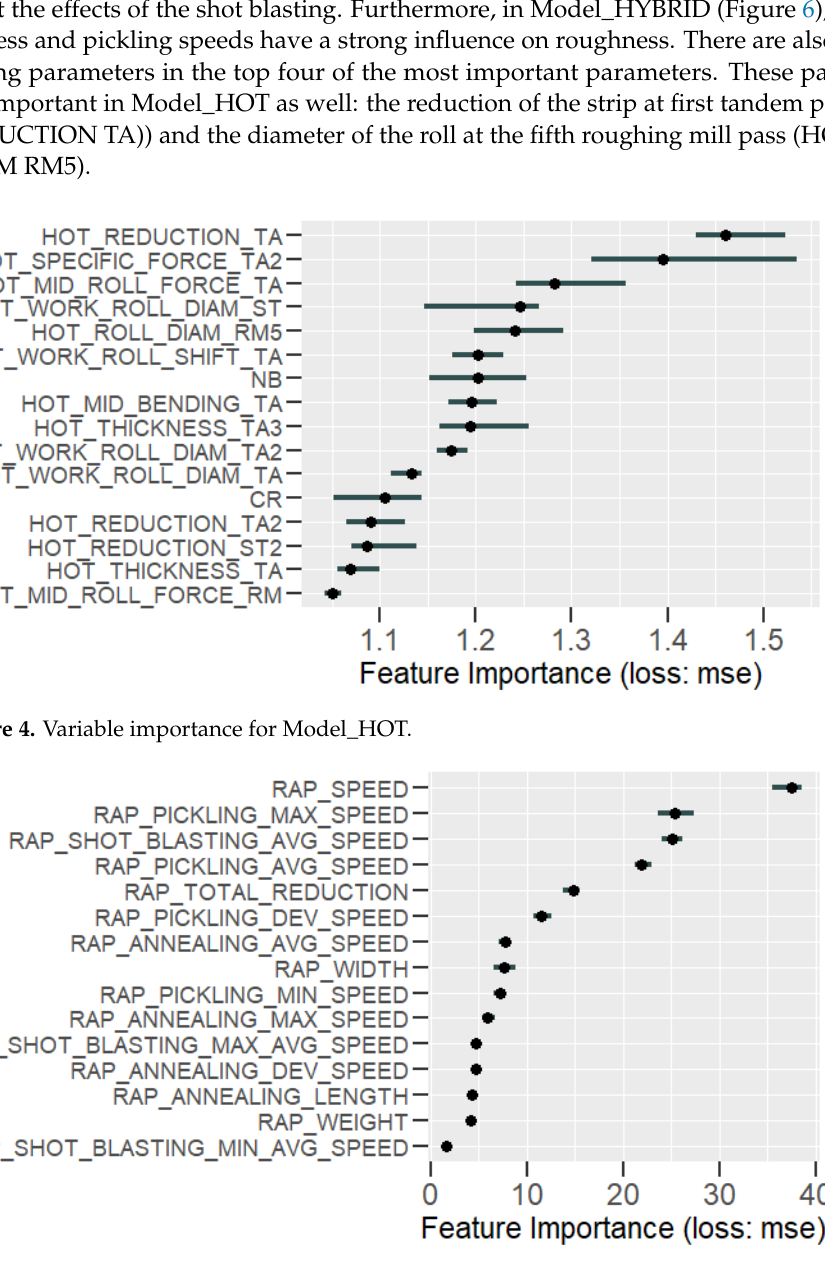
Figure 5. Variable importance for